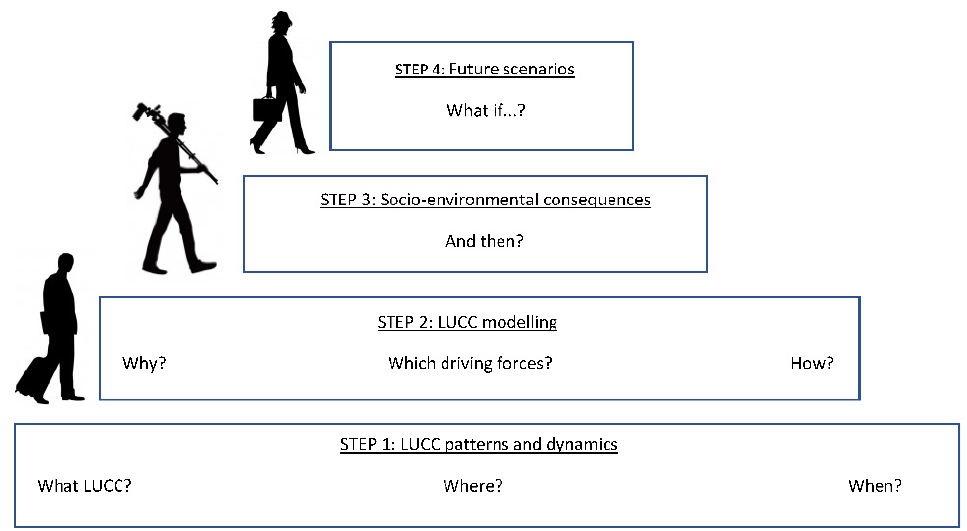
Figure 1. A workflow from broader to narrower knowledge issues illustrating the STEPLand perspective. Source: own elaboration.